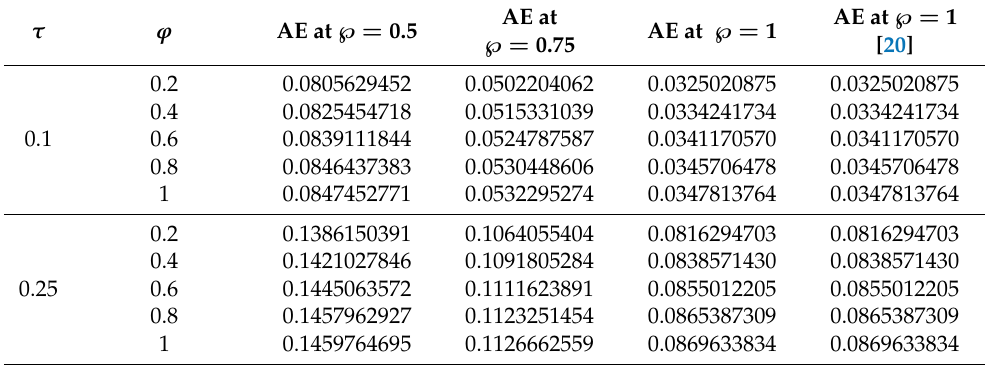
Figure 1. The analytical solution for u ( ϕ , ( τ )) and v ( ϕ , ( τ )) from Example 1. Table 1. Numerical analysis of u ( ϕ , τ ) of the example given in Example 1 with different values of ϕ , τ , and p = 2 3